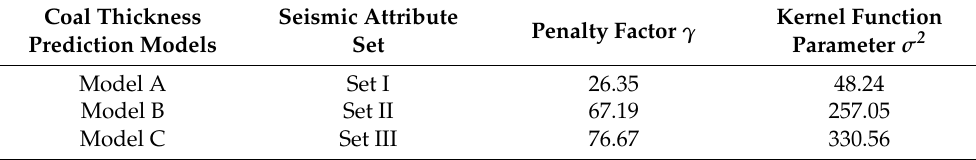
Table 3. Training results of the whale optimization algorithm for three input sample